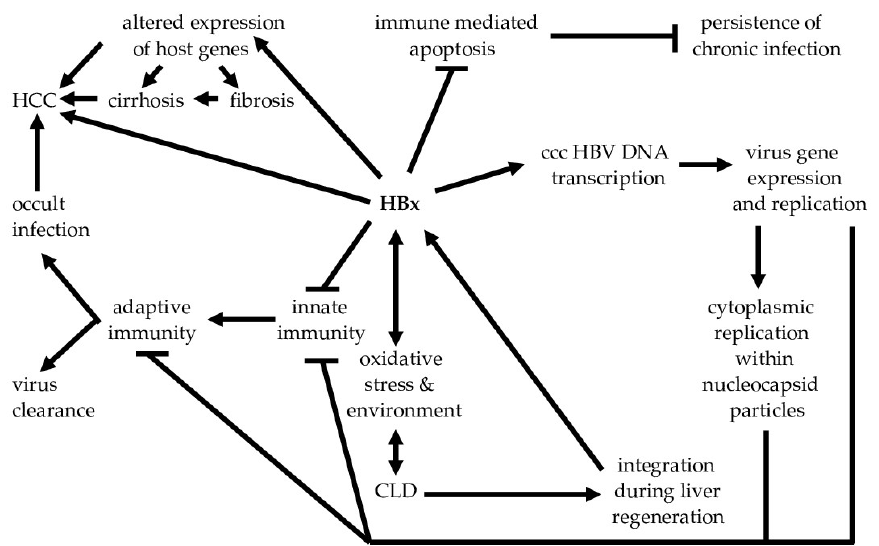
Figure 2. HBx contributes to virus gene expression and replication, which promotes both virus persistence and the pathogenesis of HCC. Details are provided within the text. Abbreviations: HBx—hepatitis B x antigen, CLD—chronic liver disease, HCC—hepatocellular carcinoma.